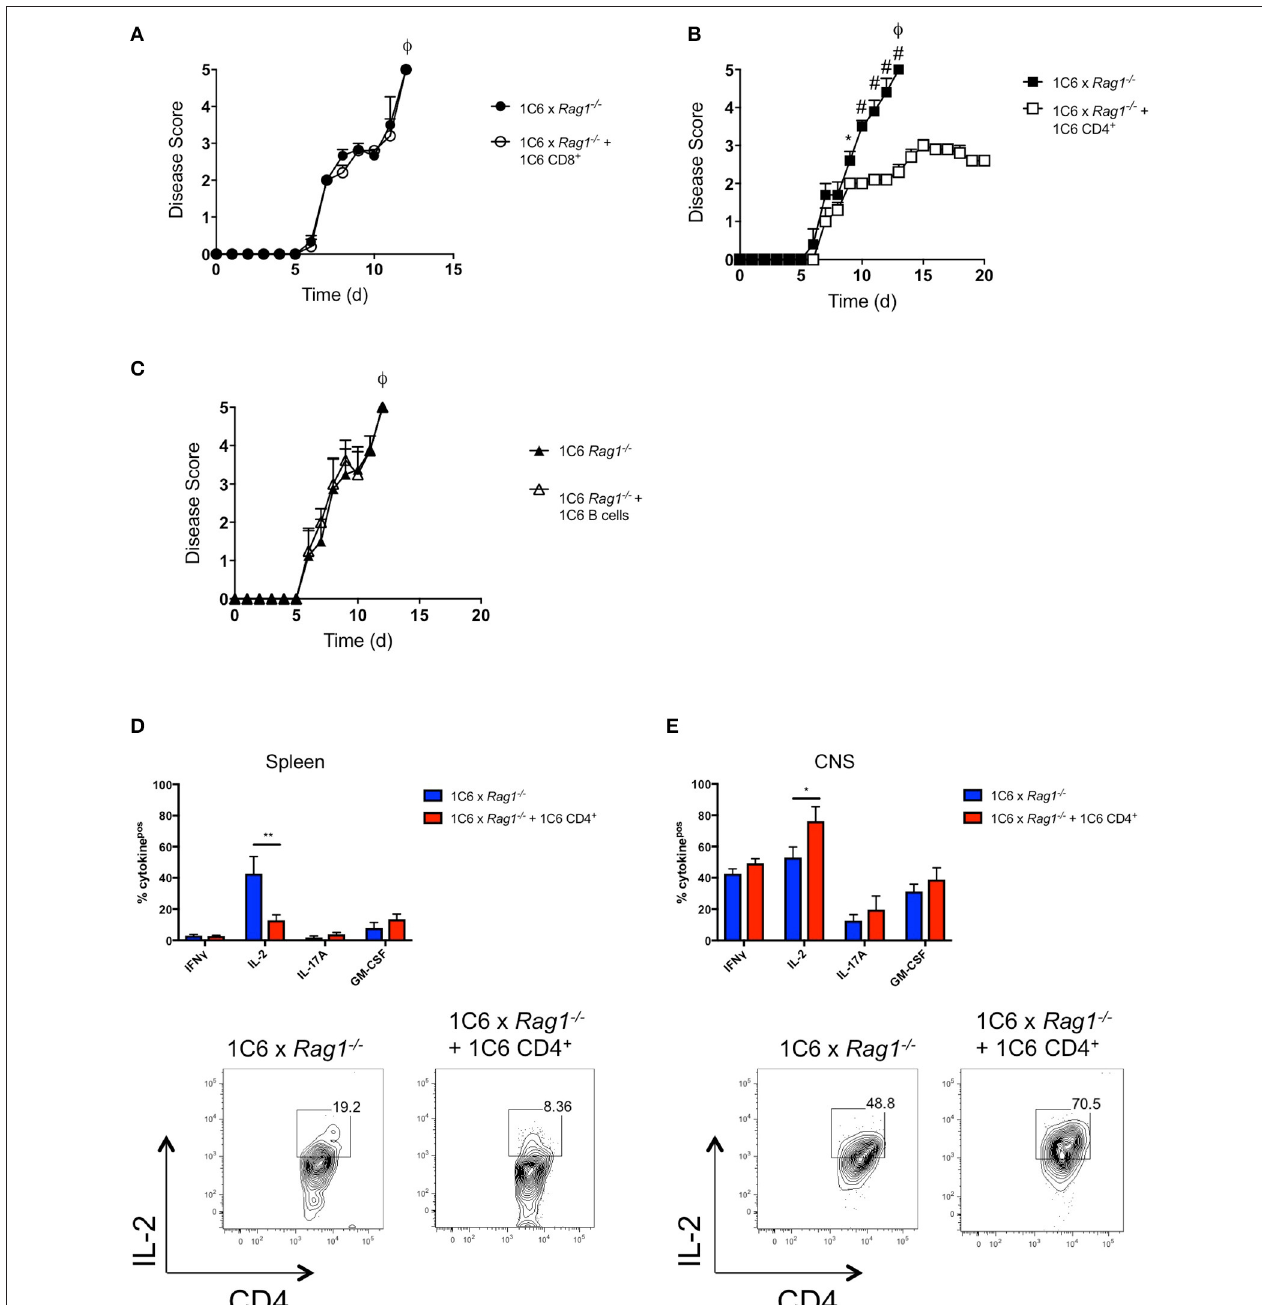
FIGURE 5 | 1C6 CD4 + T cells restrain CNS autoimmunity in 1C6 × Rag1 − / − mice. (A) Male 1C6 × Rag1 − / − mice were reconstituted ( n = 5), or not ( n = 5), with 2 × 10 6 CD4 + T cells from unmanipulated male 1C6 mice. After 7 days, mice were actively immunized with MOG [35 − 55] and were monitored for signs of EAE. Representative of 2 experiments. (B) Male 1C6 × Rag1 − / − mice were reconstituted ( n = 5), or not ( n = 5), with 2 × 10 6 CD8 + T cells from unmanipulated male 1C6 mice. After 7 days, mice were actively immunized with MOG [35 − 55] and were monitored daily for signs of EAE. * p < 0.05, two-tailed Mann-Whitney U test. φ indicates that all mice in the experimental group attained ethical endpoints. (C) Female 1C6 × Rag1 − / − mice were reconstituted ( n = 4), or not ( n = 4), with 2 × 10 6 CD19 + B cells from unmanipulated 1C6 mice. After 7 days, mice were actively immunized with MOG [35 − 55] and were monitored for signs of EAE. φ indicates that all mice in the experimental group attained ethical endpoints. * p < 0.05; # p < 0.01, two-tailed Mann-Whitney U test. φ indicates that all mice in the experimental group attained ethical endpoints. (D,E) . Spleen (D) or CNS-infiltrating (E) CD4 + T cells were isolated from immunized 1C6 × Rag1 − / − mice when they reached ethical endpoints ( n = 9), or from 1C6 × Rag1 − / − (reconstituted with 1C6 CD4 + ) that were sacrificed in parallel ( n = 4). T cells were assessed ex vivo for the indicated cytokines by flow cytometry. All data are gated on live CD4 + events. * p < 0.05; ** p < 0.01, Sidak’s multiple comparisons test after two-way ANOVA. Bottom plots, representative IL-2 expression from splenic (D) or CNS-infiltrating (E) CD4 + T cells.